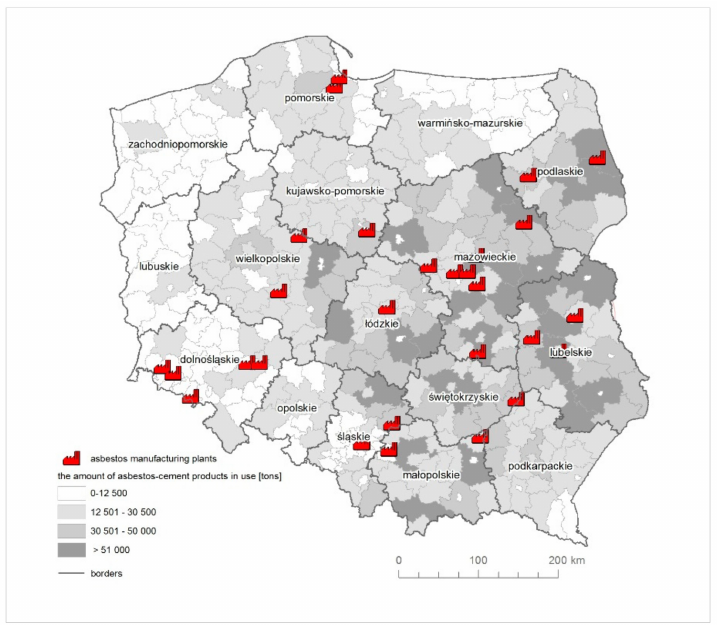
Figure 1. The quantity of asbestos-cement products in use [5] with the reference to the asbestos manufacturing